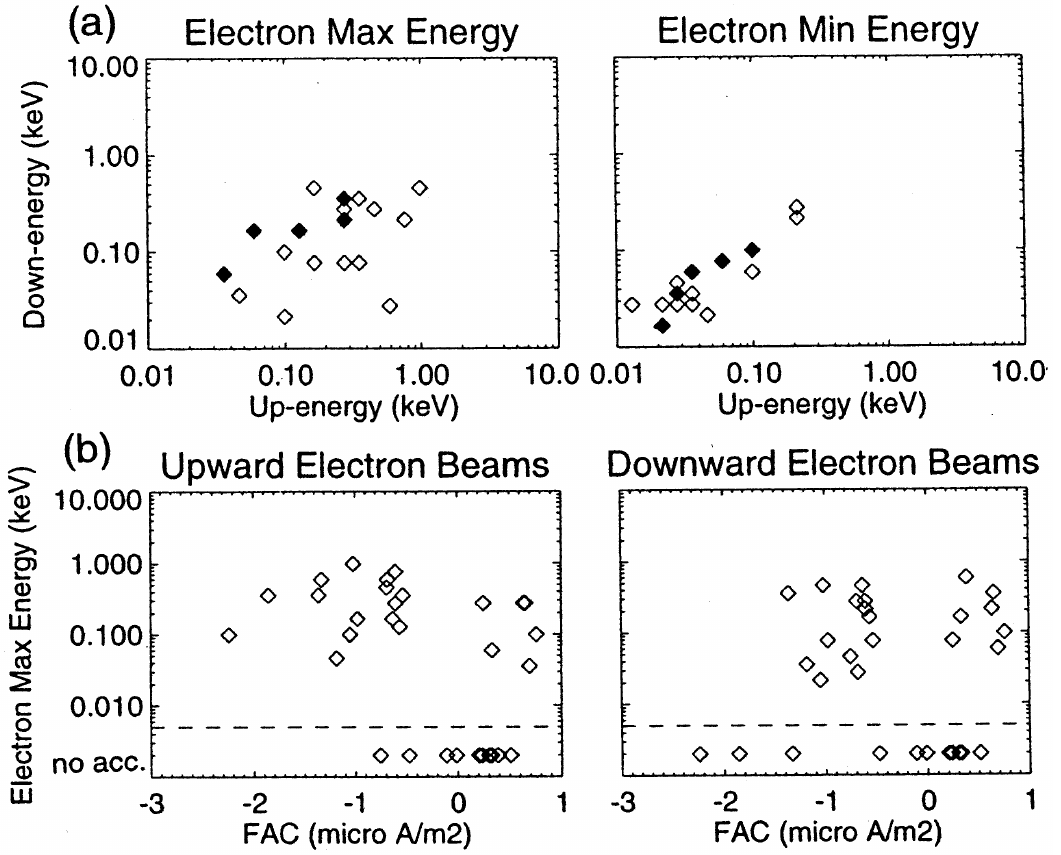
Fig. 3. (a) Comparison of upward and downward energies of counterstreaming electrons. The filled diamonds stand for the data after 6:42:30. (b) Relationship between the intensity of field-aligned current and the maximum energy of upward (left panel) and downward (right) field-ligned electron